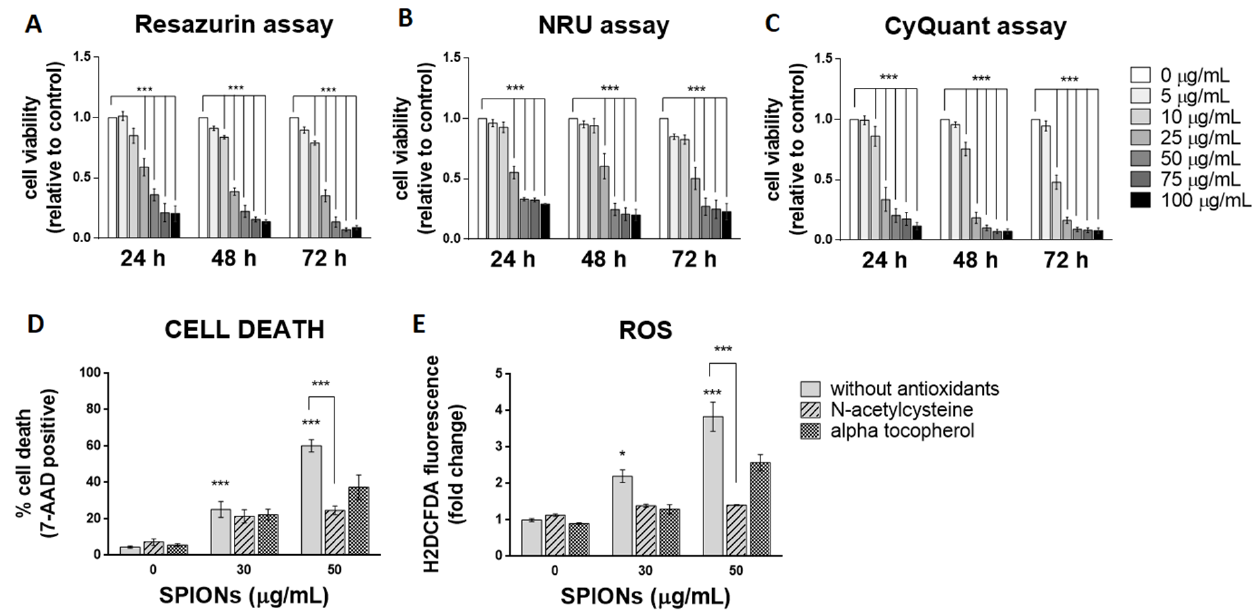
Figure 2. Silica-coated SPIONs decrease cell viability and induce elevation of reactive oxygen species (ROS). ( A – C ) HUVEC cells were treated with silica-coated SPIONs in serum-free medium for 24, 48, or 72 h. Cell viability was determined by resazurin assay ( A ), neutral red uptake (NRU) assay ( B ), and CyQuant assay ( C ). ( D , E ) HUVEC cells were treated with silica-coated SPIONs and N-acetylcysteine (NAC) (20 mM) or α-tocopherol (1 mM) for 24 h. Cell death ( D ) and ROS ( E ) were quantified by flow cytometry using 7-aminoactinomycin D (7-AAD) staining and CM-H 2 DCFDA staining, respectively. Values on the graphs are means ± standard error of the mean (SEM) of at least three independent experiments; statistically significant differences in mean values are indicated (*, p < 0.05; ***, p < 0.001; one-way ANOVA with Tukey post hoc test).